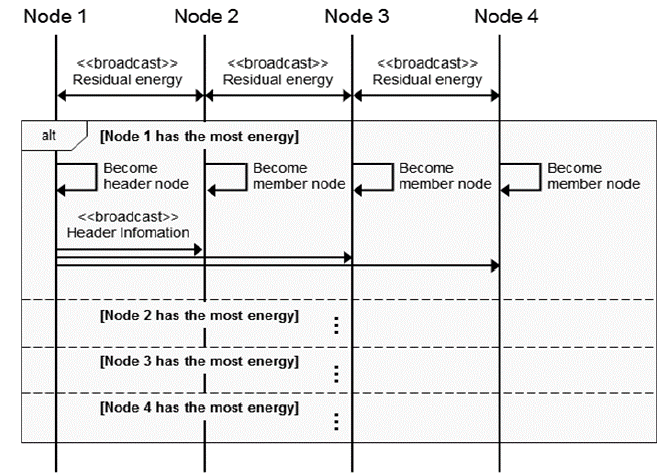
Figure 2. Advertisement phase sequence diagram.